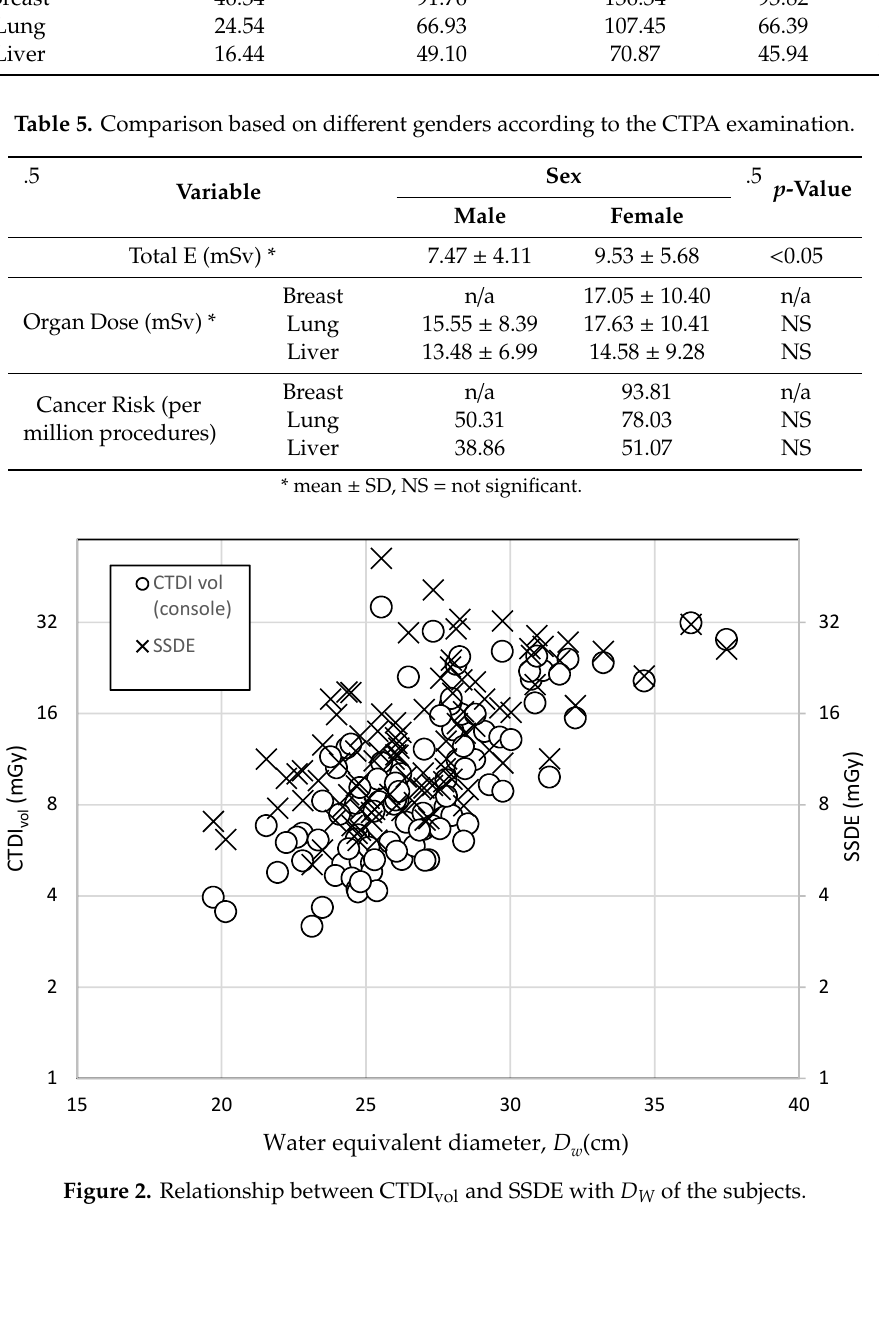
Table 4. Mean cancer risk estimation according to group study per one million procedures. Cancer risk (Per